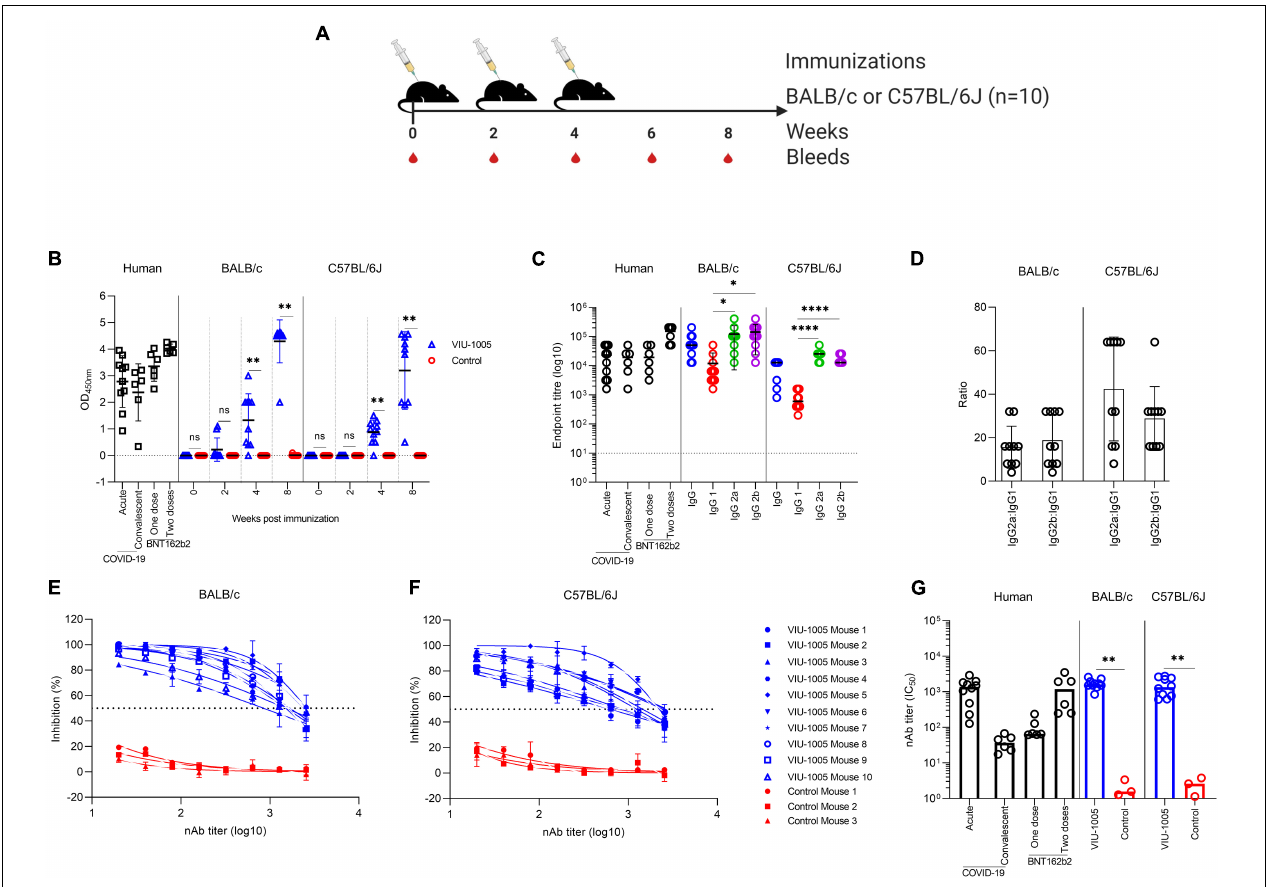
FIGURE 2 | Antibody response against SARS-CoV-2 after intramuscular needle-based immunization in BALB/c and C57BL/6J mice. (A) Mice ( n = 10) were intramuscularly immunized via needle injection with 3 doses of 100 µ g at 2-week intervals using either VIU-1005 or control plasmid. The timeline shows the bleeding and immunization regimen. (B) OD values of S1-specific binding total IgG at a 1:100 dilution from each mouse were determined by ELISA at 2, 4, and 8 weeks post first immunization on day 0. IgG responses from acutely infected patients (3–4 weeks post-onset), convalescent individuals (3–4 months post-onset) and individuals who received a single or two doses of BNT162b2 mRNA vaccine (3 weeks post-vaccination) are also shown to compare the data with the immunized mouse sera. (C) End-point titers of S1-specific total IgG, IgG1, IgG2a, and IgG2b were determined by ELISA in samples collected at week 8 from immunized mice. End-point titers of total IgG from acutely infected patients (3–4 weeks post-onset), convalescent individuals (3–4 months post-onset) and individuals who received a single or two doses of BNT162b2 mRNA vaccine (3 weeks post-vaccination) are also shown to compare the data with the immunized mouse sera. (D) IgG2a:IgG1 and IgG2b:IgG1 ratios were calculated in samples collected from immunized mice at week 8. Serum samples from (E) BALB/c or (F) C57BL/6J mice that were intramuscularly immunized with 3 doses of 100 µ g at 2-week intervals using either VIU-1005 ( n = 10) or control plasmid ( n = 3) were collected at week 8 post first immunization and serially diluted and tested in duplicate for their neutralizing activity against rVSV- (cid:49) G/SARS-2-S*-luciferase pseudovirus as described in the “Materials and Methods.” (E,F) Neutralizing activity from serum samples collected from each mouse and (G) nAb titers (IC 50 ). nAbs from acutely infected